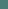
Nav1.6-BAD-GFP displays wild-type currents.ND7/23 cells or DIV6 rat hippocampal neurons were transfected with either the wild-type channel or Nav1.6-BAD-GFP and the resulting TTX-resistant currents analyzed by whole-cell voltage-clamp in the presence of 300 nM TTX. A) Representative current traces from the indicated cell type and construct. Scale bars represent 500 pA and 5 ms. B) Summary of current densities for WT and Nav1.6-BAD-GFP expressed in hippocampal neurons. The difference in mean peak current density (116.8±63.06, n = 16 and 48.42±35.73 pA/pF, n = 20,) was significant (p<0.001) although many of the cells expressing the Nav1.6-BAD-GFP channel had expression levels similar to cells expressing the wild-type channel. Currents were recorded 2 days post-transfection. C) Voltage-dependence of fast-inactivation and activation for wild-type Nav1.6 (•) and Nav1.6-BAD-GFP (∎) as measured in ND cells 36–48 hours post-transfection. Error bars are mean ± s.d.